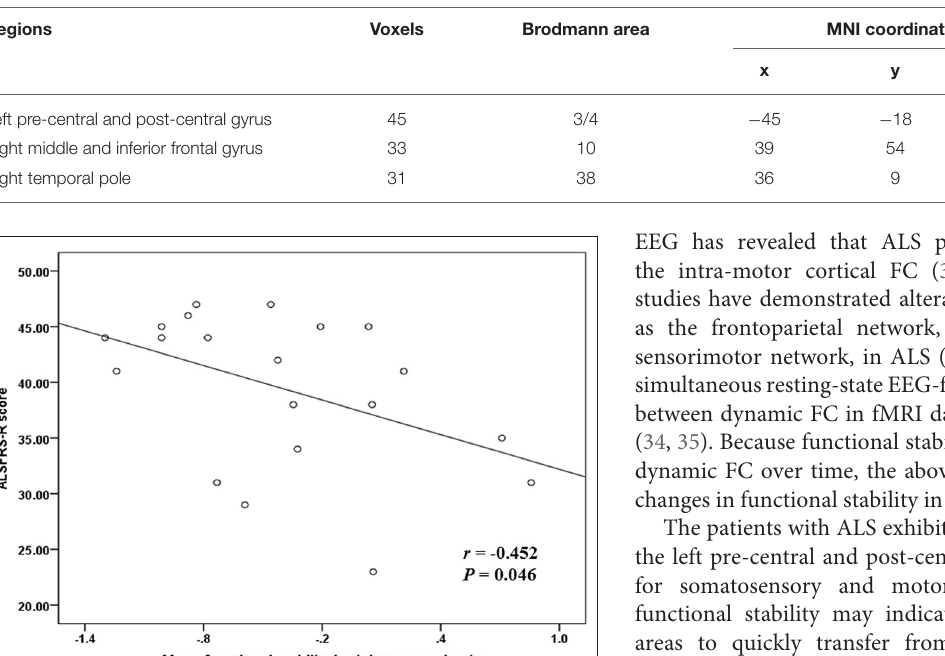
TABLE 2 | Regions with between-group difference in functional stability.